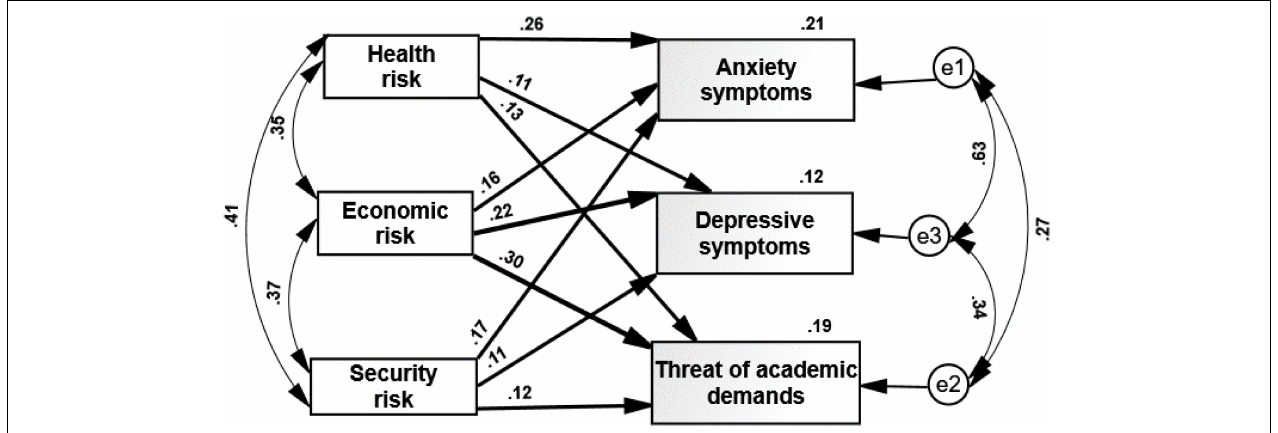
FIGURE 2 | Path analysis for three threats predicting anxiety and depressive symptoms and threat of academic demands. All the paths are significant ( p < 0.01).